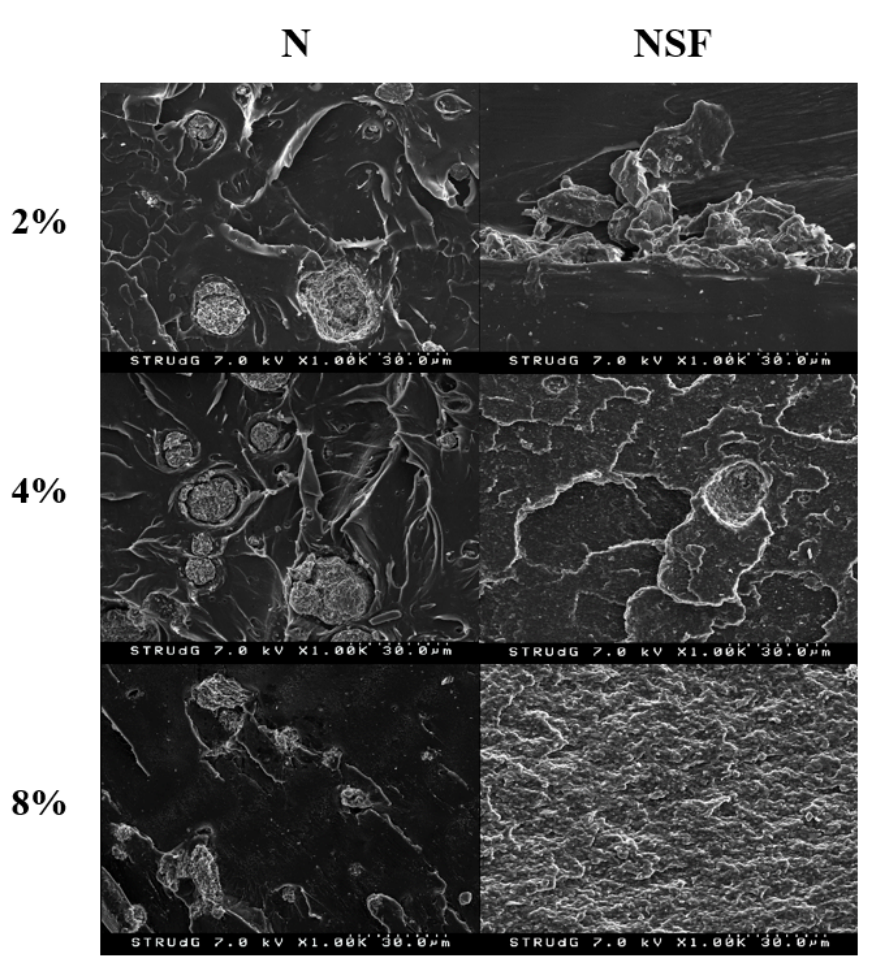
Figure 6. SEM micrographs PLA nanocomposites regarding the reinforcement content and the nanoclay type.